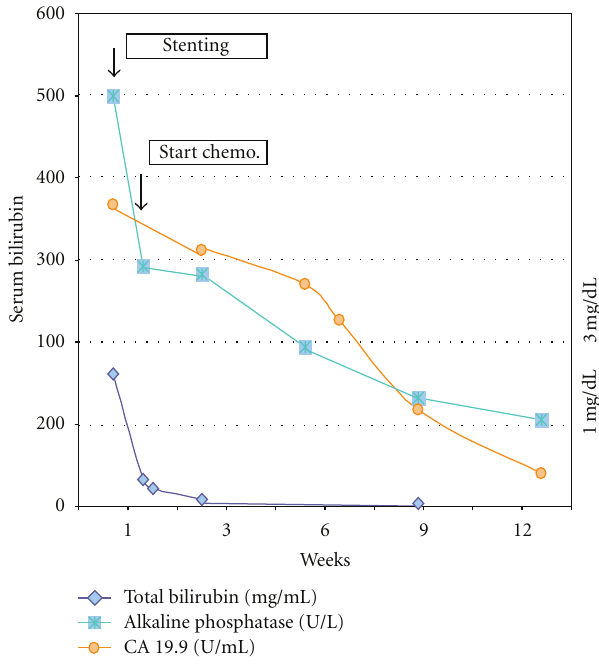
Figure 5: Evolution of liver function test and tumormarker (CA 19.9) in patient